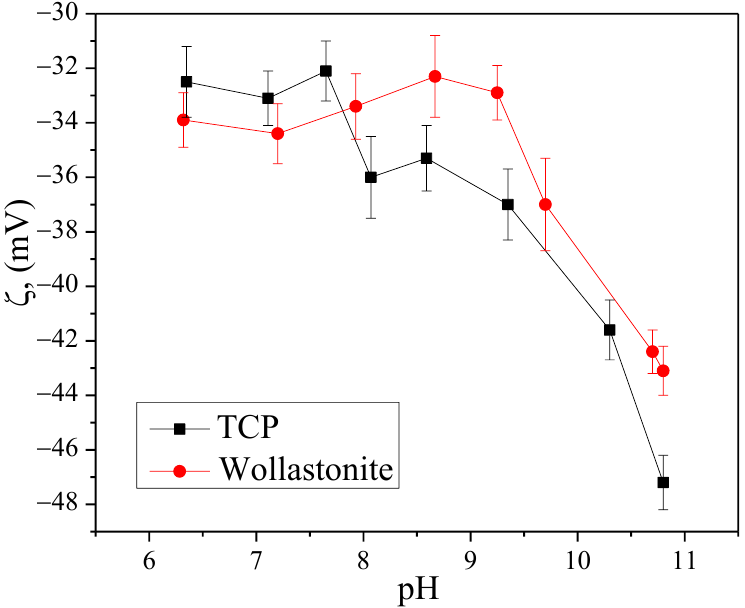
Figure 2. Graphs of the ζ of the TCP and wollastonite particles versus the pH. Due to the growth of the dielectric layer on the surface of the magnesium substrate, a decrease in current density occurred over time (Figure 3a). This process varied in intensity depending on the composition of the electrolyte. Figure 3a shows that the current density was maximal when the coating was formed in the electrolyte with wollastonite and minimal when the coating was applied in the electrolyte containing both types of particles. Figure 3b demonstrates the change in the initial current density versus the voltages of the coating’s deposition. It can be seen that with increasing process voltage, the initial current density raises. When WS coatings were formed at various values of the process voltage, the initial current densities were almost three times higher than the initial current densities observed during the deposition of TC and TW coatings (Figure 3b).